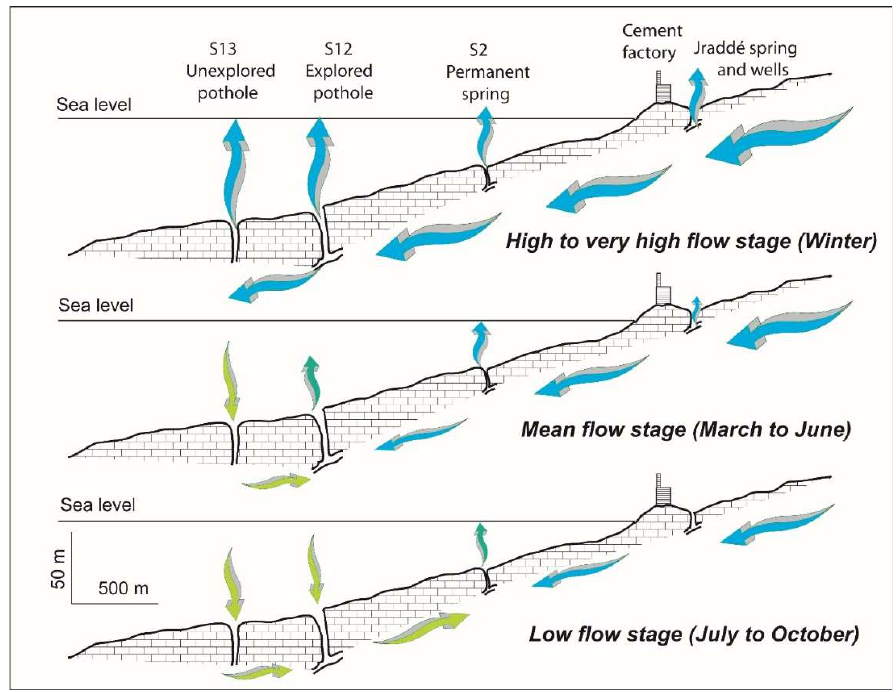
Figure 3. Cross section along the Nahr el Asfour River paleo-valley, North Lebanon. The Chekka submarine springs discharge groundwater of a 250 km 2 recharge area in Mount Lebanon. The deepest flooded karst features swallow sea water during low flow stage. The permanent spring S2 discharges brackish water (modified from [31]). Blue arrows: fresh water flow; green arrows: sea water flow; blue green arrows: brackish water.